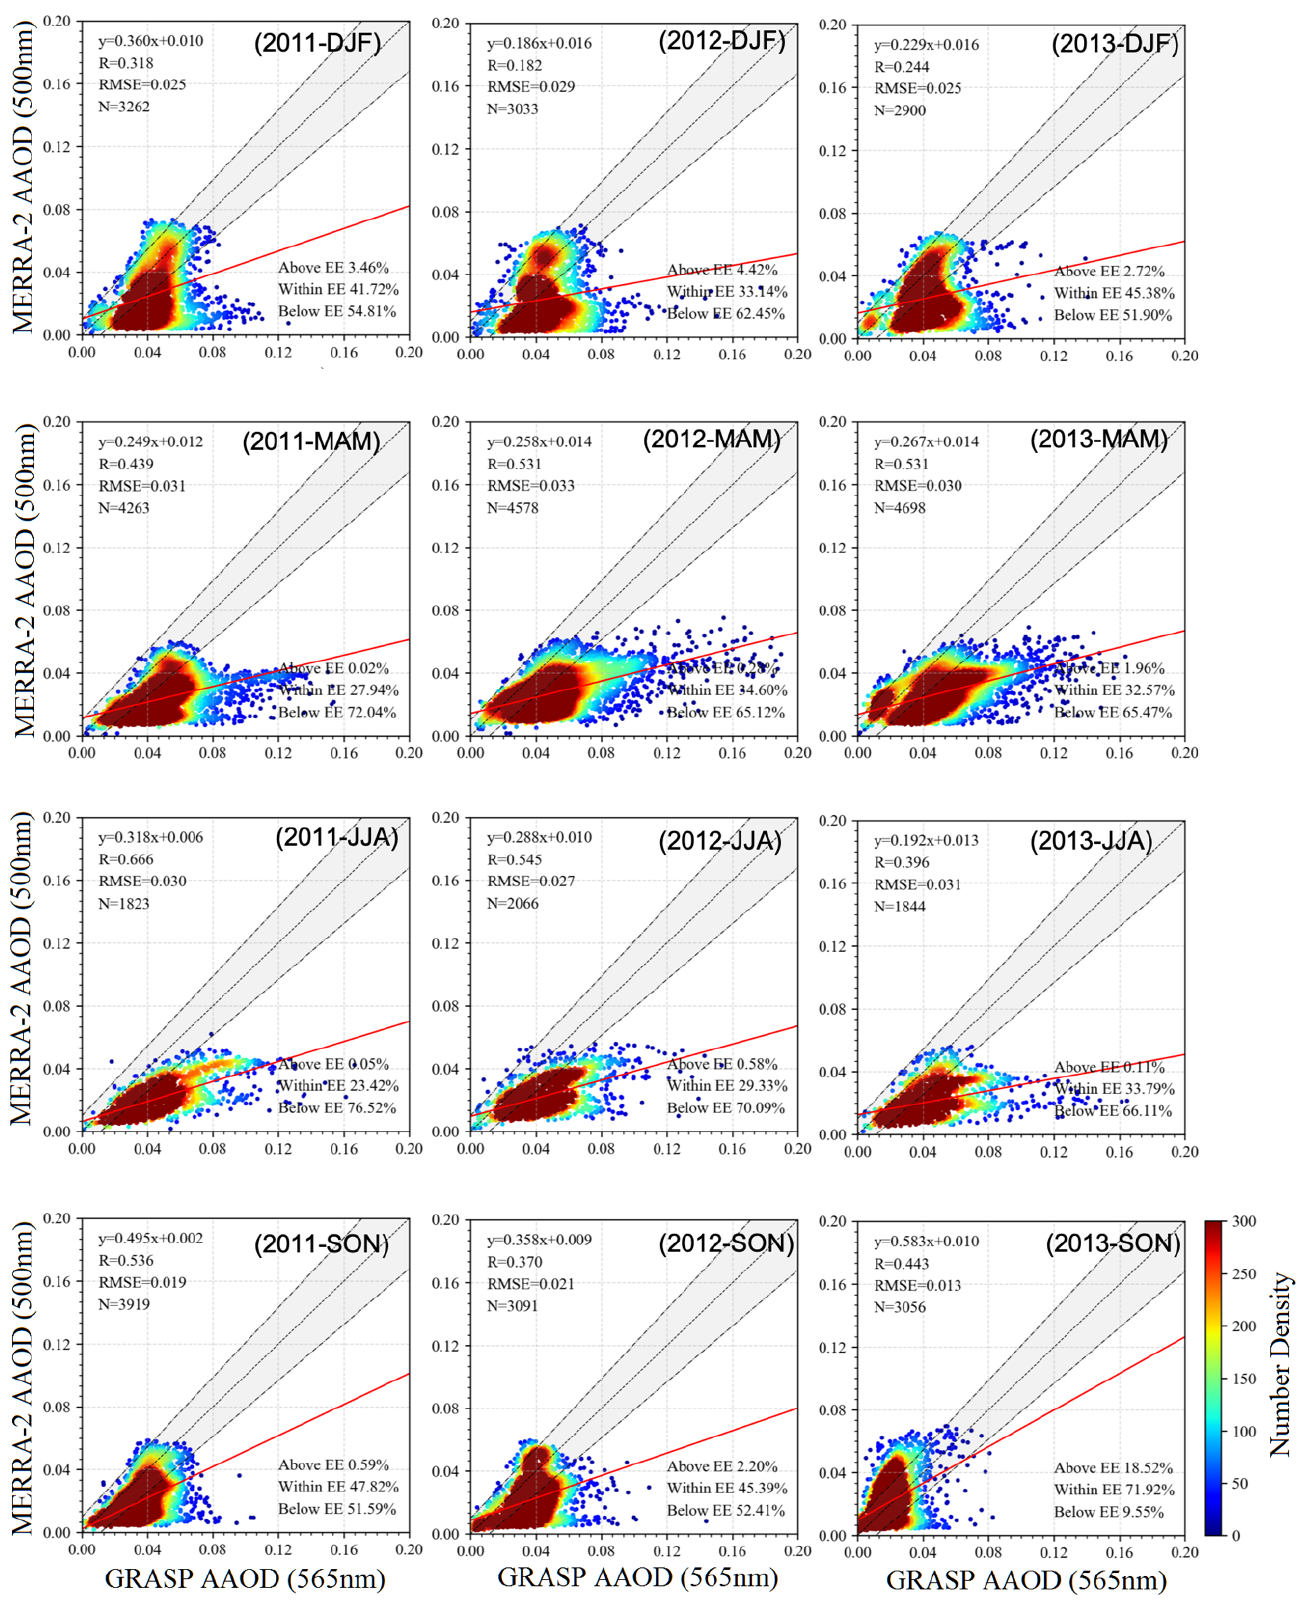
Figure 12. Same as Figure 6, but for AAOD.